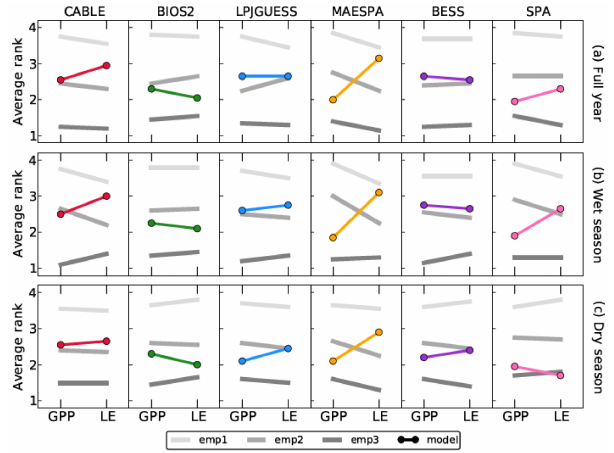
Figure 7. Rank plot showing the average performance of six terres- trial biosphere models (TBMs) across the North Australian Tropical Transect (NATT). The closer a model’s rank is to 1, the better its performance is at predicting latent energy (LE) and gross primary productivity (GPP). Empirical benchmarks representing increasing levels of complexity (emp1 <emp2<emp3) are represented as grey lines, and coloured lines denote each model. The lines have no sci- entific value and are used for visual purposes only. Benchmarking and model evaluation data are from Whitley et al.